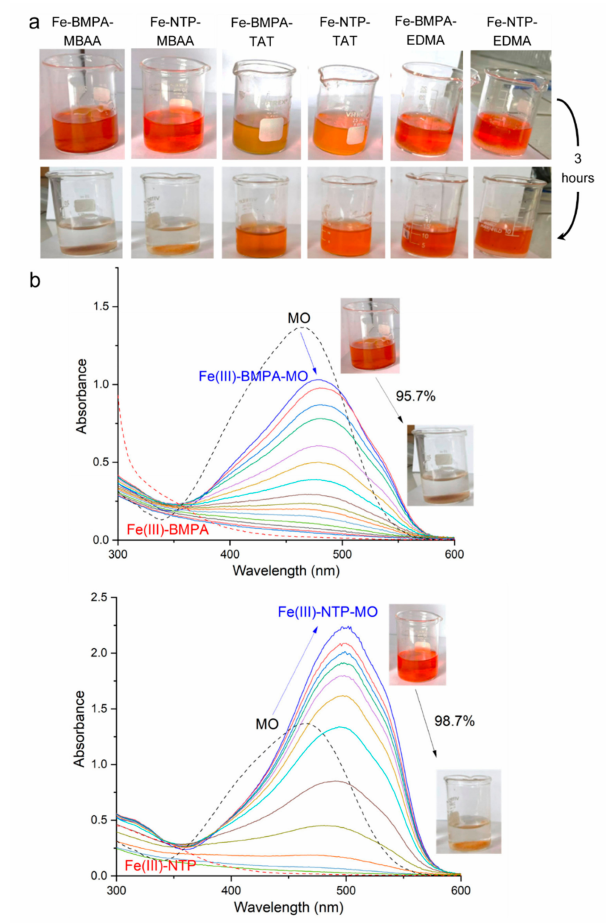
Figure 5. Catalytic performance of the Fe(III)-complex-imprinted polymers towards the oxida- tive degradation of MO in the presence of H 2 O 2 . ( a ) Change in the color of the solutions during the experiments. ( b ) Time evolution of the supernatant UV-vis spectral profile for Fe(III)-BMPA- MBAA and Fe(III)-NTP-MBAA systems. Conditions: T = 20.0 ◦ C; 3 h; [MO] = 6 × 10 − 5 mol L − 1 ,